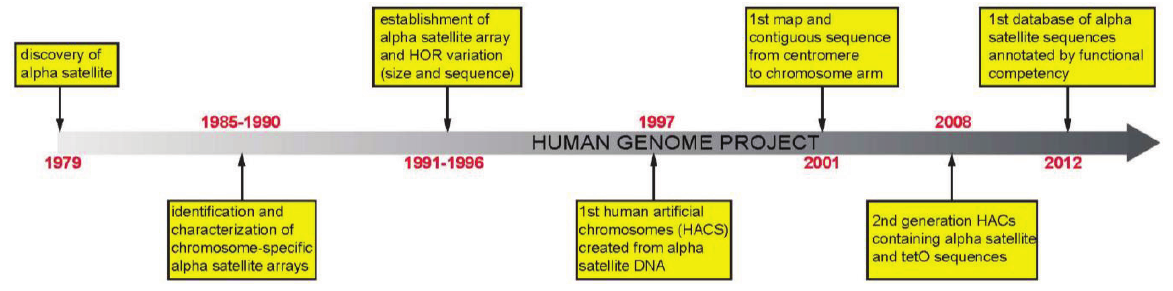
Figure 5. Timeline of major discoveries in human centromere genomics. Since the discovery of alpha satellite DNA in 1979, the understanding of the sequence, organization, and functional aspects of this sequence flourished during the Human Genome Project era. Recent years have shown the use of human artificial chromosomes (HACs) and the creation of the first database of alpha satellite sequences linked to their functional